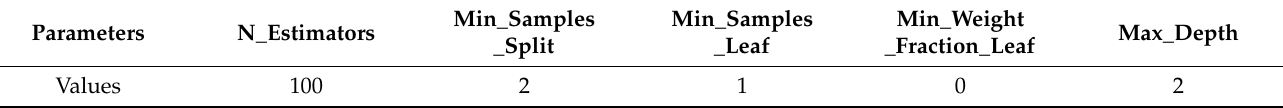
Figure 3. Characteristic importance of marine environmental factors. Table 2. Five parameters used for the calculation of the characteristic importance.